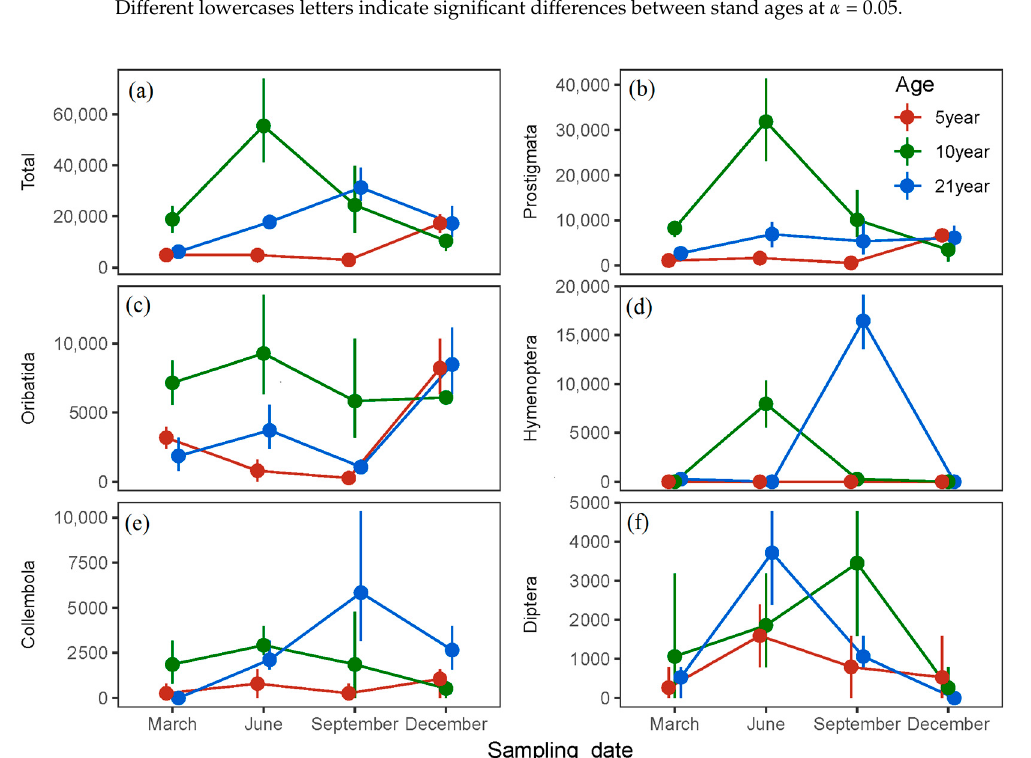
Different lowercases letters indicate significant differences between stand ages at α = 0.05.